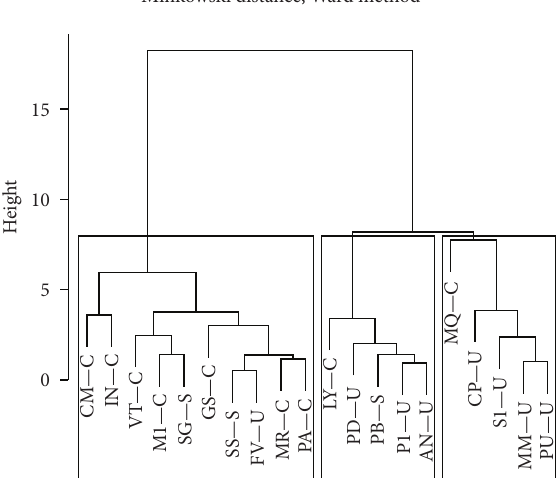
F 8: Dendrogram obtained from cluster analysis using absorbance. Branches are labeled by species and groups (canopy C, subcanopy S, and understory U). It was cut at a distance (height) such that it generates three clusters; these are shown by rectangular boxes.